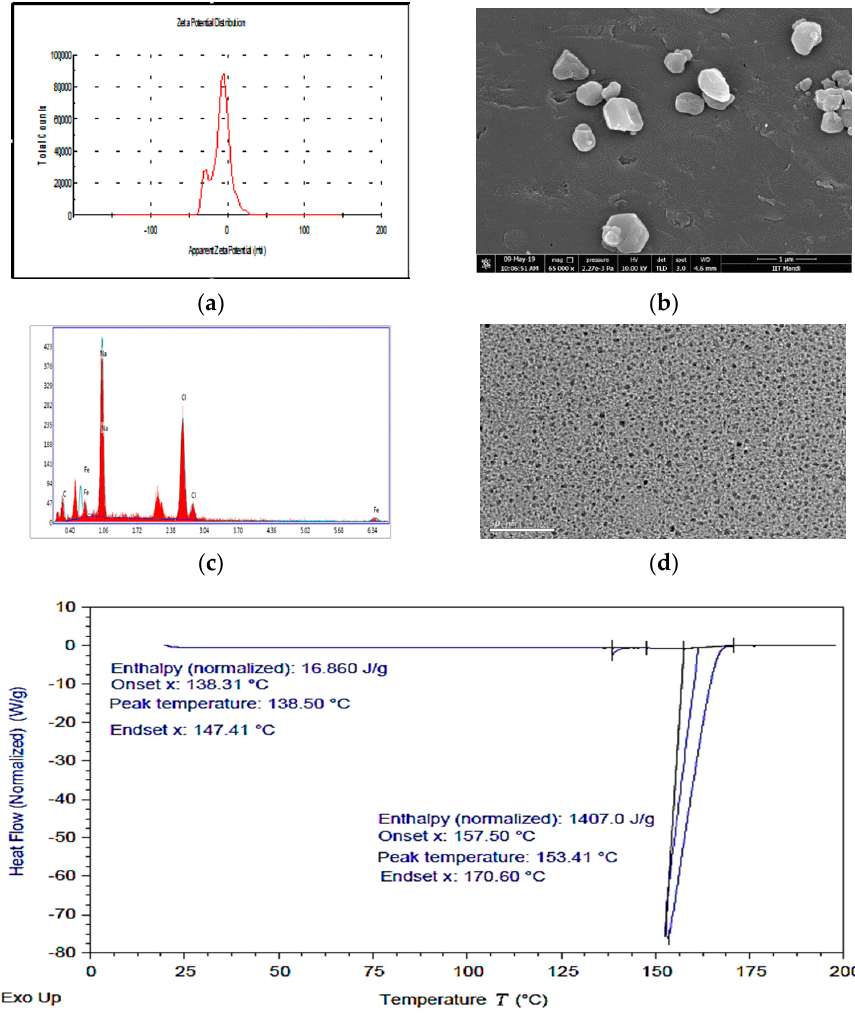
Figure 3. ( a ): apparent zeta potential of IHNPs, nanoparticles capped with 1% gum arabic; ( b ): Scanning electron micros- copy image of IHNPs, capped with 1% gum arabic (2500×); ( c ): Energy-dispersive X-ray spectroscopy image of IHNPs, capped with 1% gum arabic; ( d ): Transmission electron microscopy image of IHNPs, capped with 1% gum arabic (50 nm); ( e ): Thermal stability of gum arabic stabilized IHNP’s, using a differential scanning technique. The calorimetry was particularly applied to evaluate the changes in phase transitions.